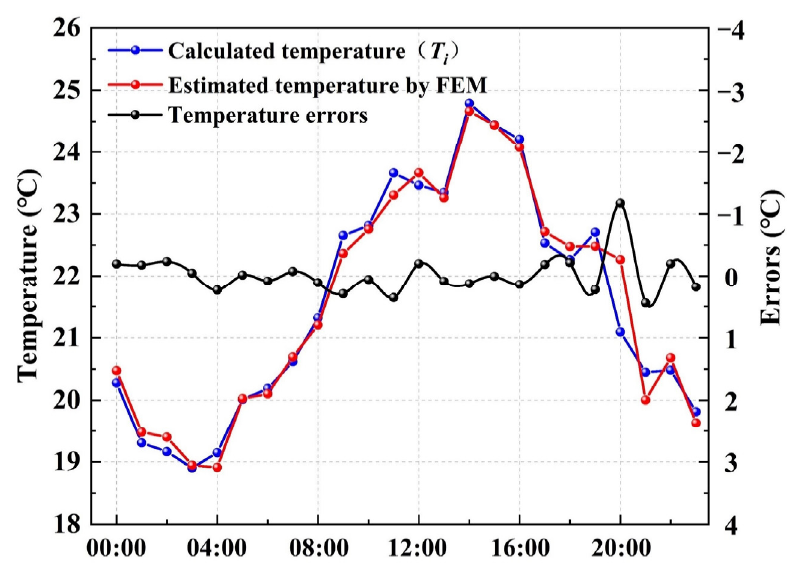
Figure 10. A comparison of the cable conductor temperature calculation